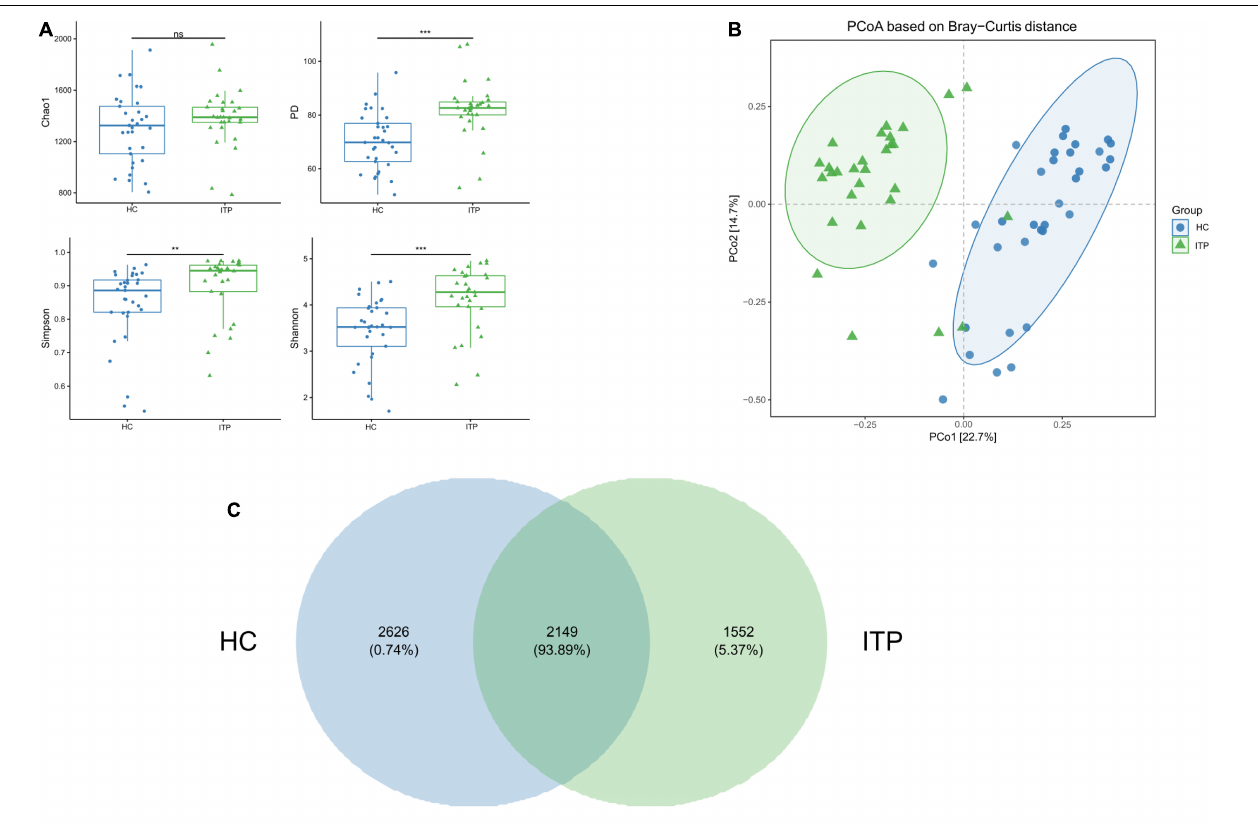
FIGURE 1 | Significant differences of gut microbial community between ITP patients and healthy controls. (A) The alpha diversity indexes include Chao 1, PD whole tree, Simpson, and Shannon. There are significant differences in PD whole tree, Simpson, and Shannon, except for Chao1. (B) PCoA is a convenient method to observe the degree of difference and the rule of variation among samples. Each dot represents a sample. The more similar the microbial community composition, the closer the dots. The plot shows a distinct difference between ITP patients and healthy controls. (C) A Venn plot is used to demonstrate the bacterial microbiota structure, assessing which species are common and unique among groups or samples. ** p < 0.01, *** p <